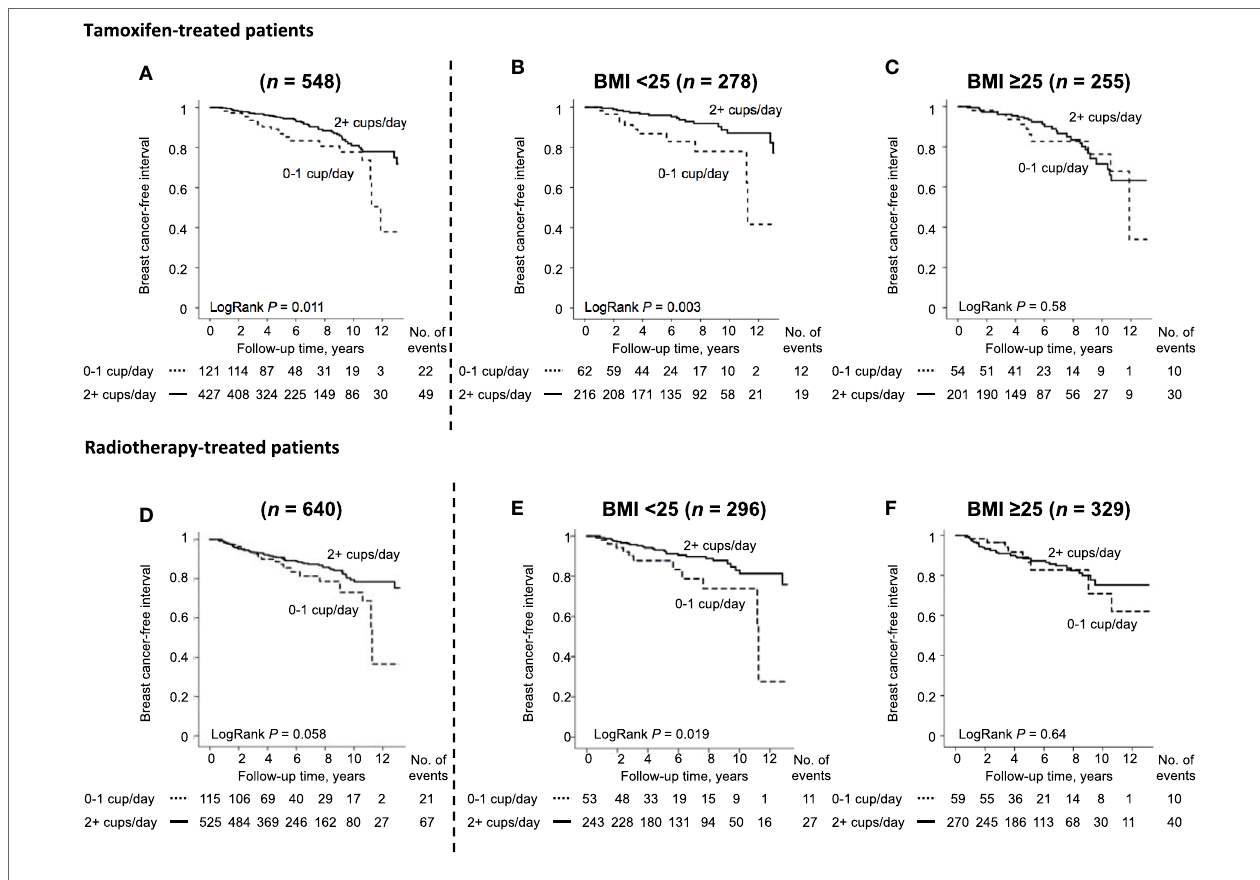
FigUre 2 | Breast cancer-free interval in tamoxifen-treated patients with ER + tumors, (a) irrespective of body mass index (BMI), (B) in patients with BMI < 25 kg/m 2 , (c) in patients with BMI ≥ 25 kg/m 2 and in radiotherapy-treated patients irrespective of ER status, (D) irrespective of BMI, (e) in patients with BMI < 25 kg/m 2 , (F) in patients with BMI ≥ 25 kg/m 2 . As this is an ongoing study, there are fewer patients with longer follow-up